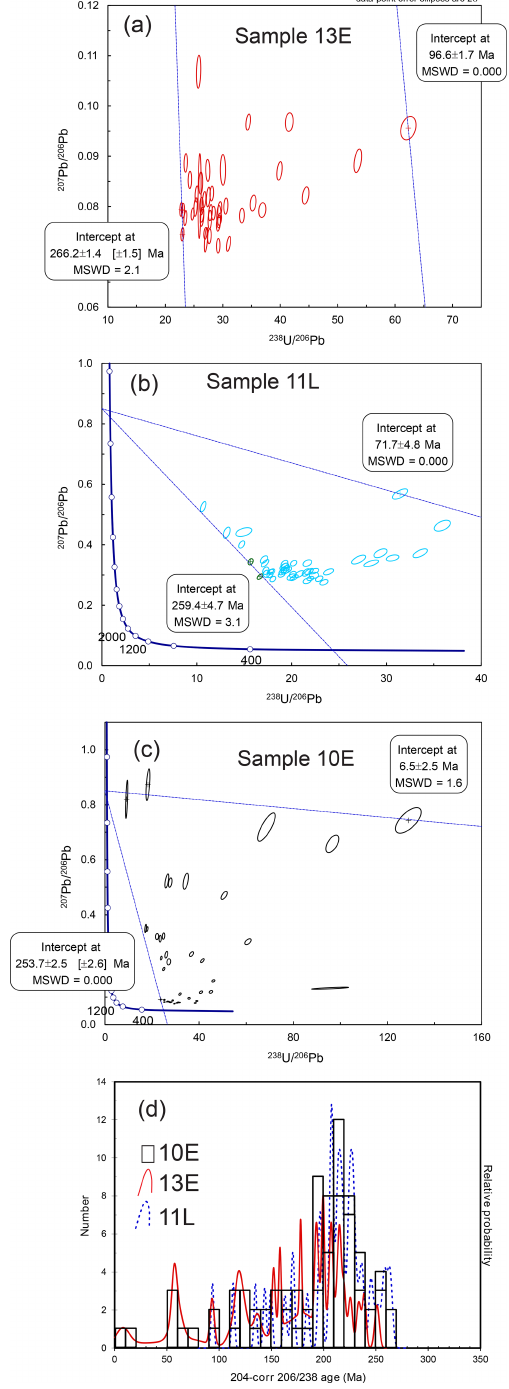
Figure 7. Titanite geochronology. (a–c) Tera–Wasserburg plots for samples 13E, 11L and 10E. Error ellipses are plotted at 2 σ . The lines fit to the data give the interpreted crystallisation age (left most intercept), and the minimum disturbed age is given by the lower intercept. (d) Probability density plot for samples 13E, 11L and 10E showing the range of interpreted crystallisation ages and the timing of the interpreted reheating events.